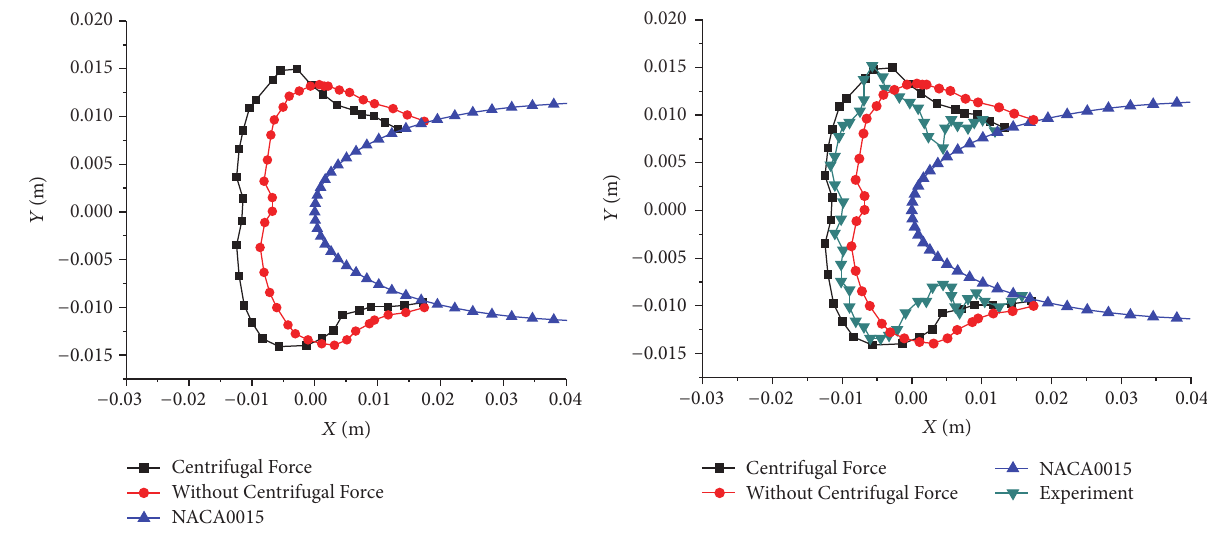
Figure 6: Influence of centrifugal force on ice shape.